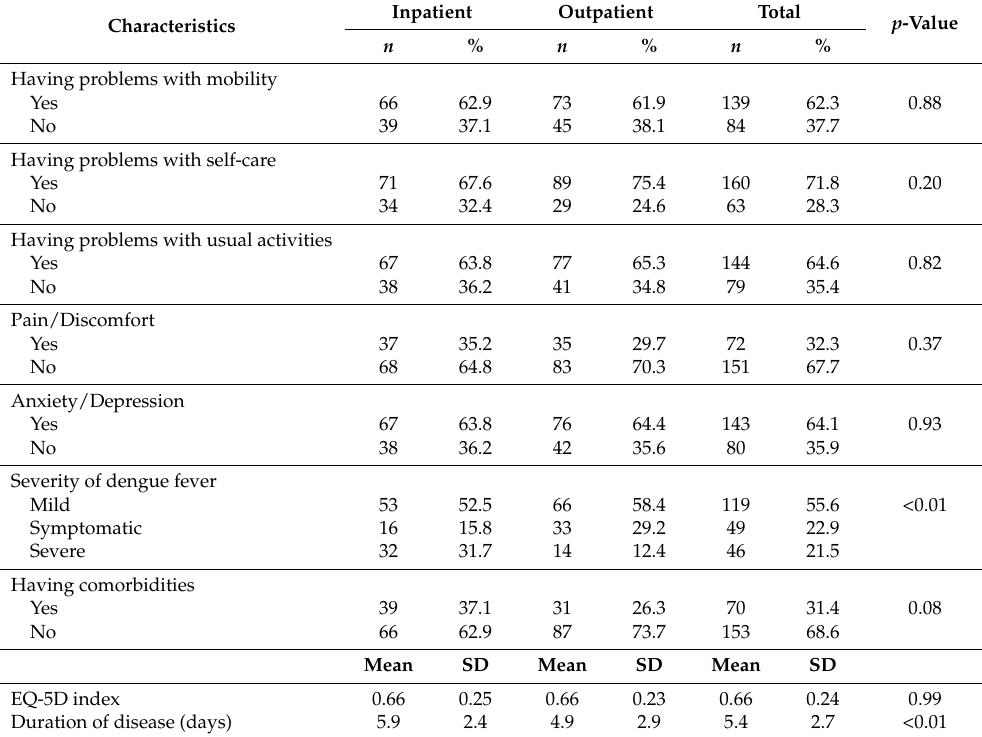
Table 2. Health status and the health-related quality of life of patients with dengue fever.